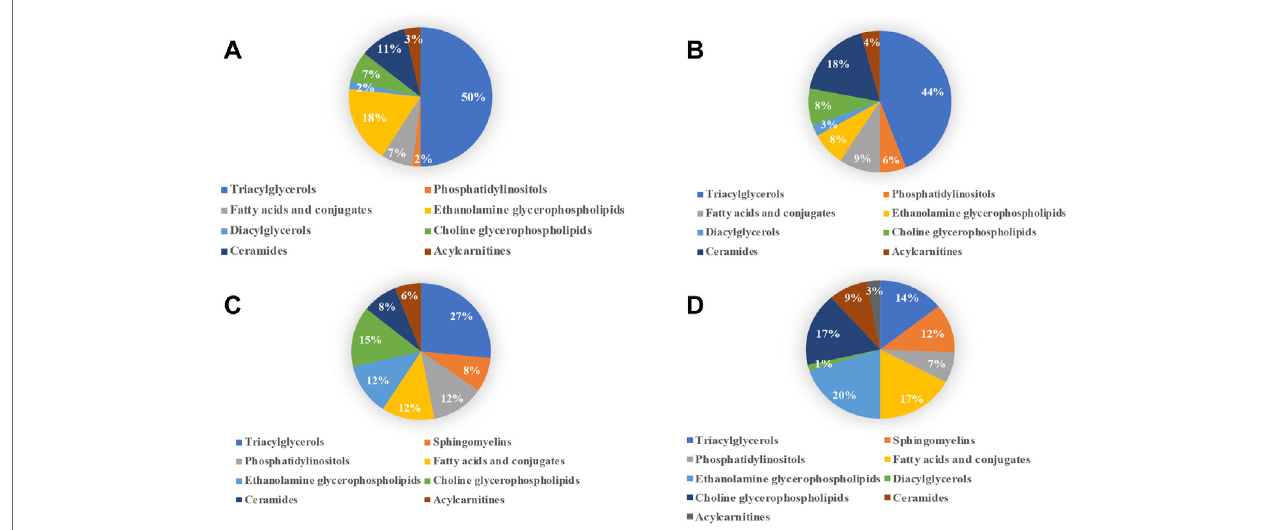
FIGURE 7 | Subgroup classi fi cation of lipid disturbances of the four models versus their NC groups. (A) ANIT group vs. ANIT-C group. (B) DDC group vs. DDC-C group. (C) EE group vs. EE-C group. (D) LCA group vs. LCA-C group.